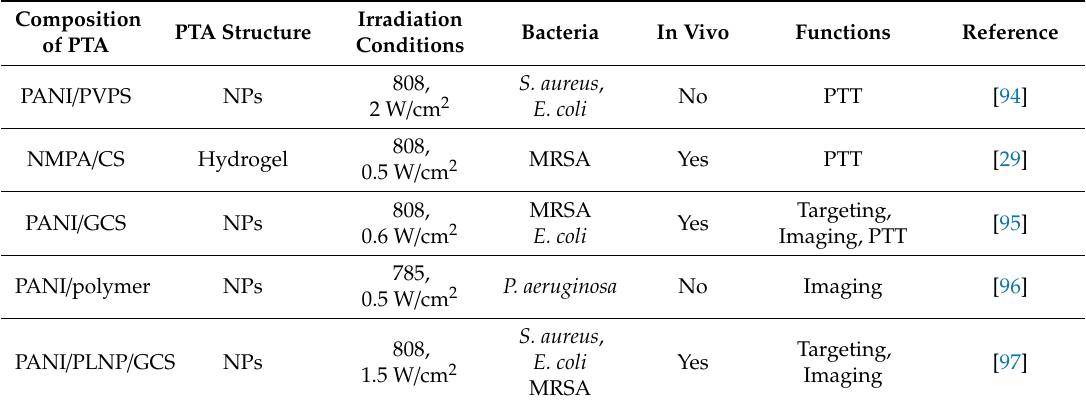
Table 2. Summary of PANI-based photothermal agents for bacterial infection